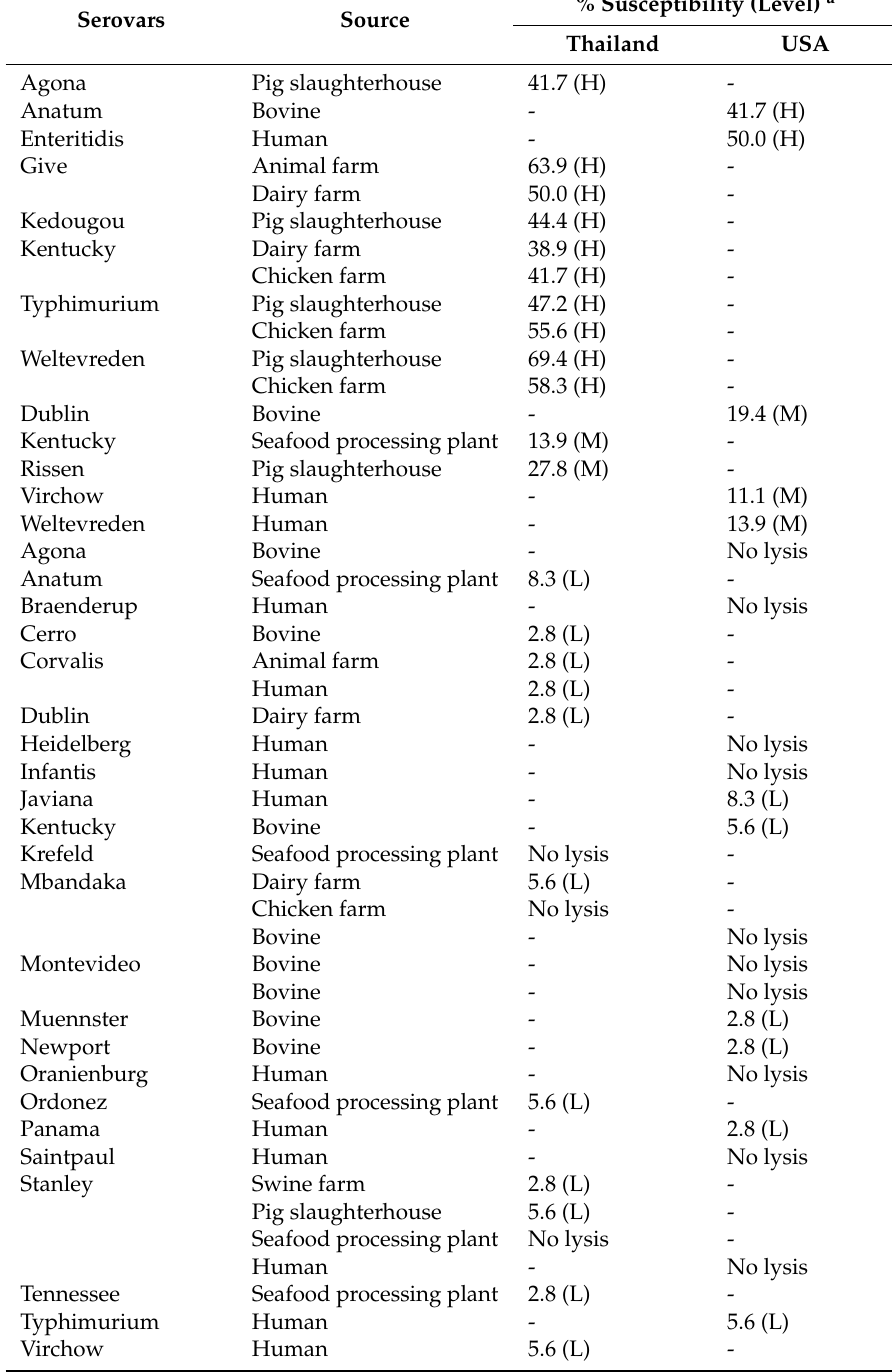
Table 4. Phage susceptibility of different Salmonella serovars recovered from various